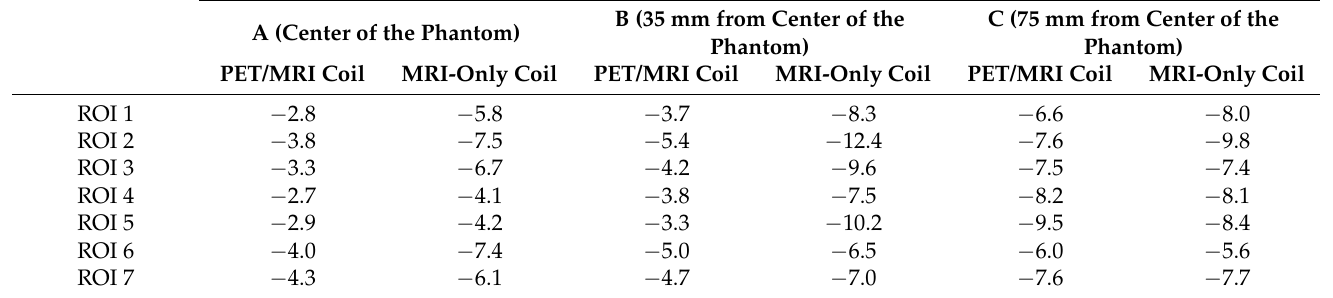
Table 2. The average percentage difference from the no surface coil configuration was calculated at three locations: ( A ) mid-phantom (center of the coil), ( B ) at the MRI-only coil electronic housing, and ( C ) at the PET/MRI coil electronic housing. The PET/MRI coil showed a lower percentage difference in activity concentration compared to the no surface coil configuration at location A and B as compared to the results from the MRI-only coil for all ROIs. At location C, both coils showed similar differences from the no surface coil configuration.